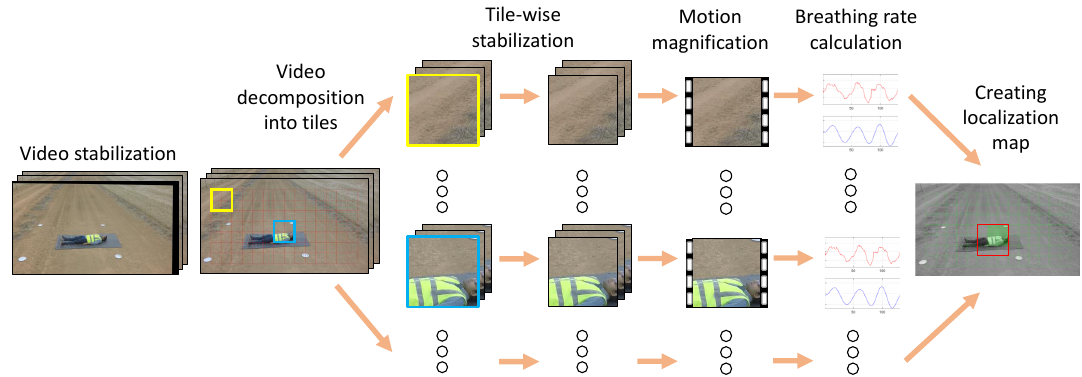
Figure 1. Schematic diagram of the proposed